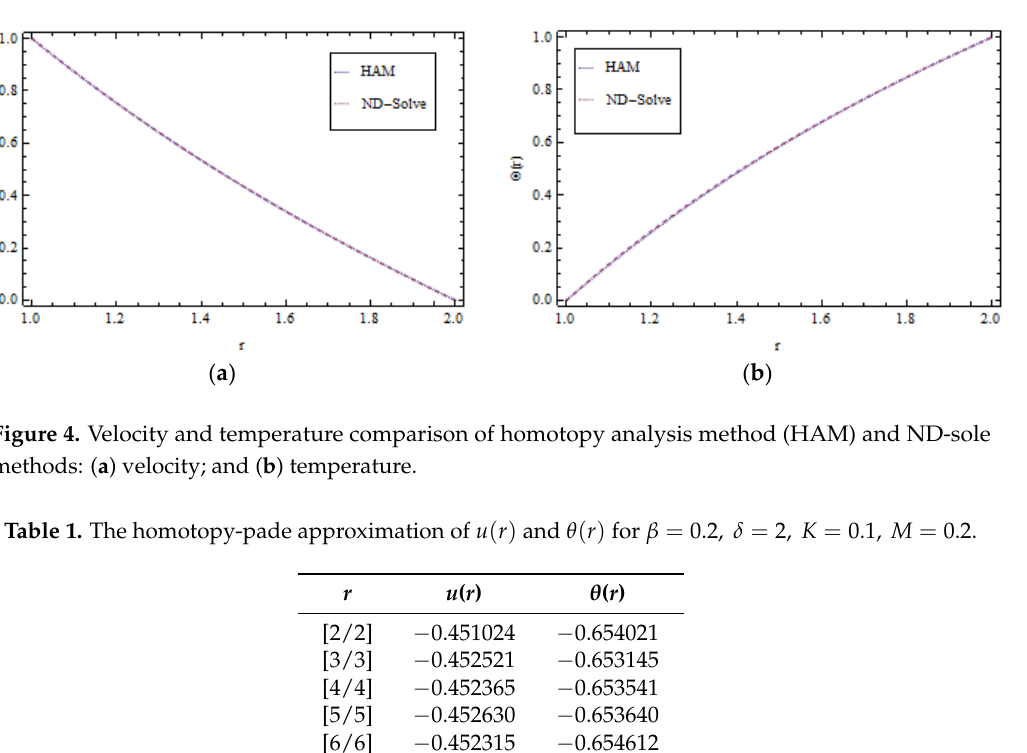
Figure 3. The ℏ − curve of velocity and temperature profiles for 20th-order approximation: ( a ) velocity; and ( b ) temperature.